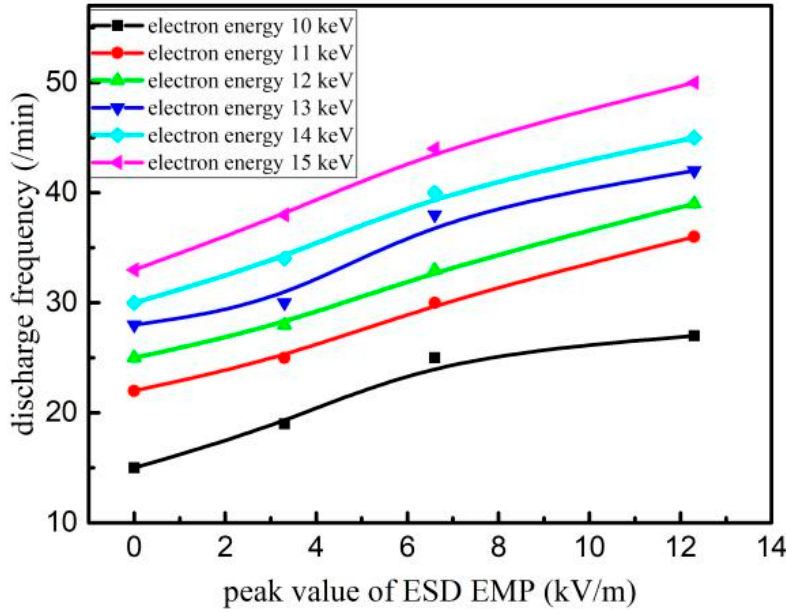
Figure 12. The change trend of discharge frequency of battery array with radiation field intensity.